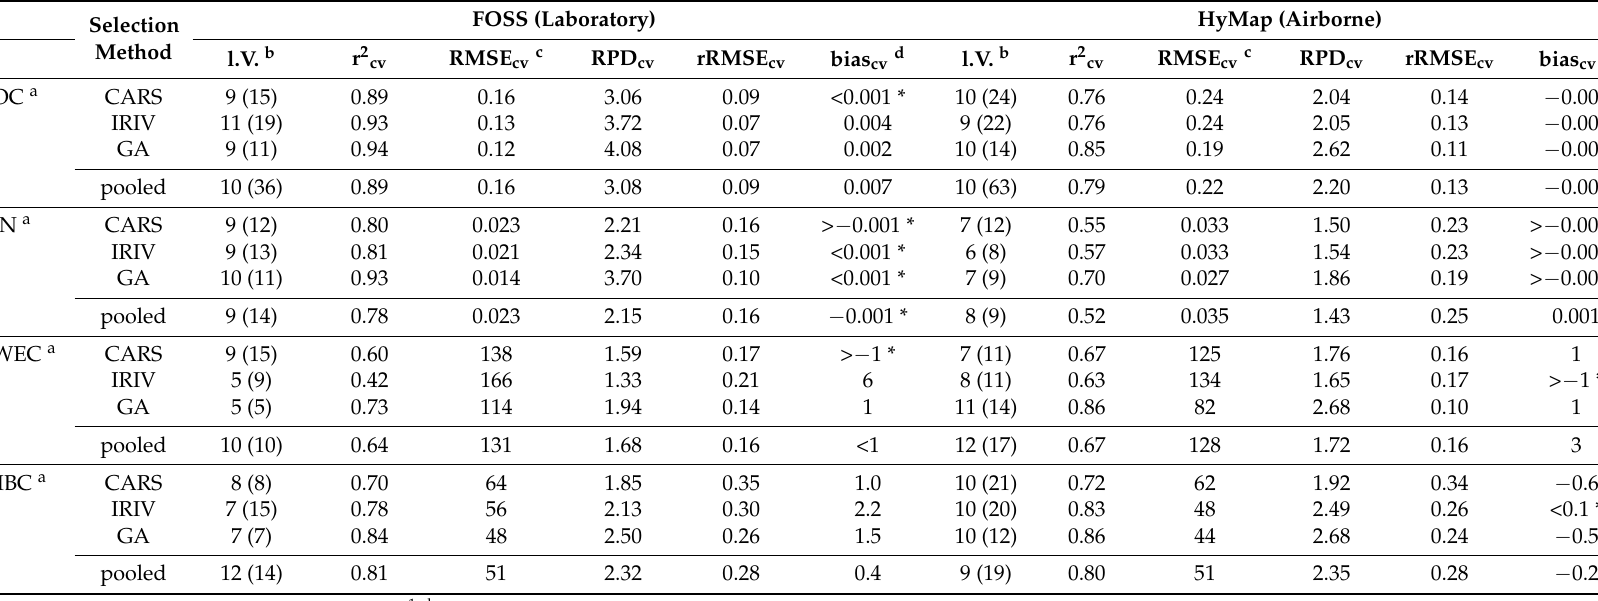
Table 4. Statistics of estimates from FOSS and HyMap spectra using PLSR combined with different spectral variable selection methods (LOO cross-validated results, n =